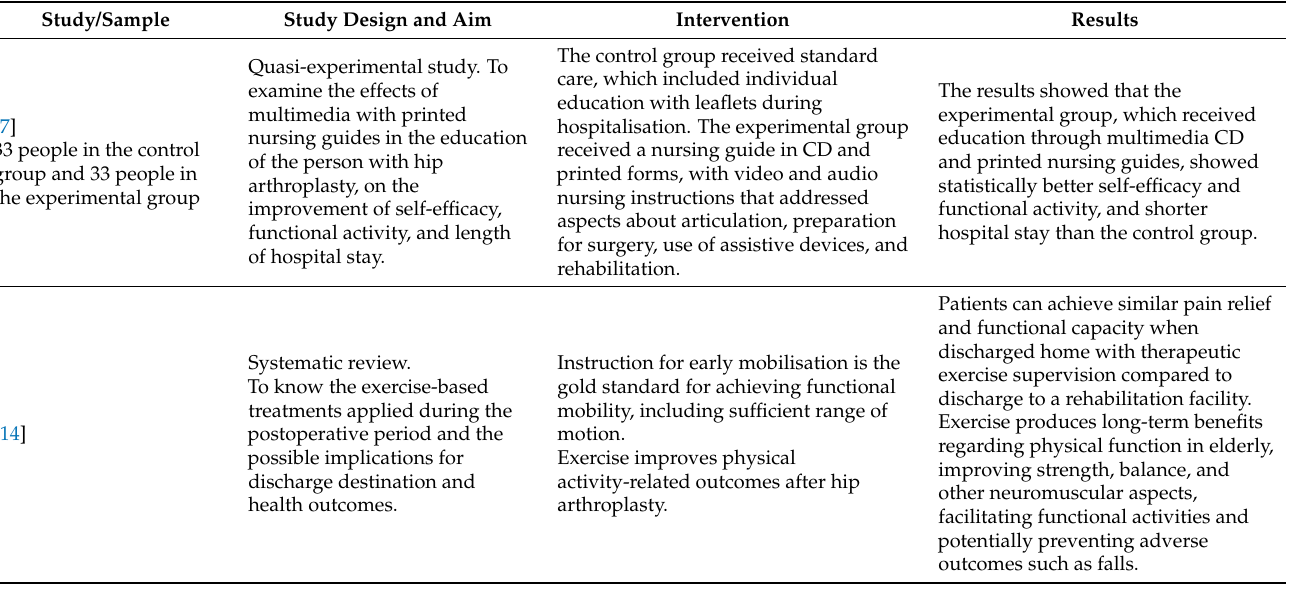
Table 3. Data extraction. Lisbon,